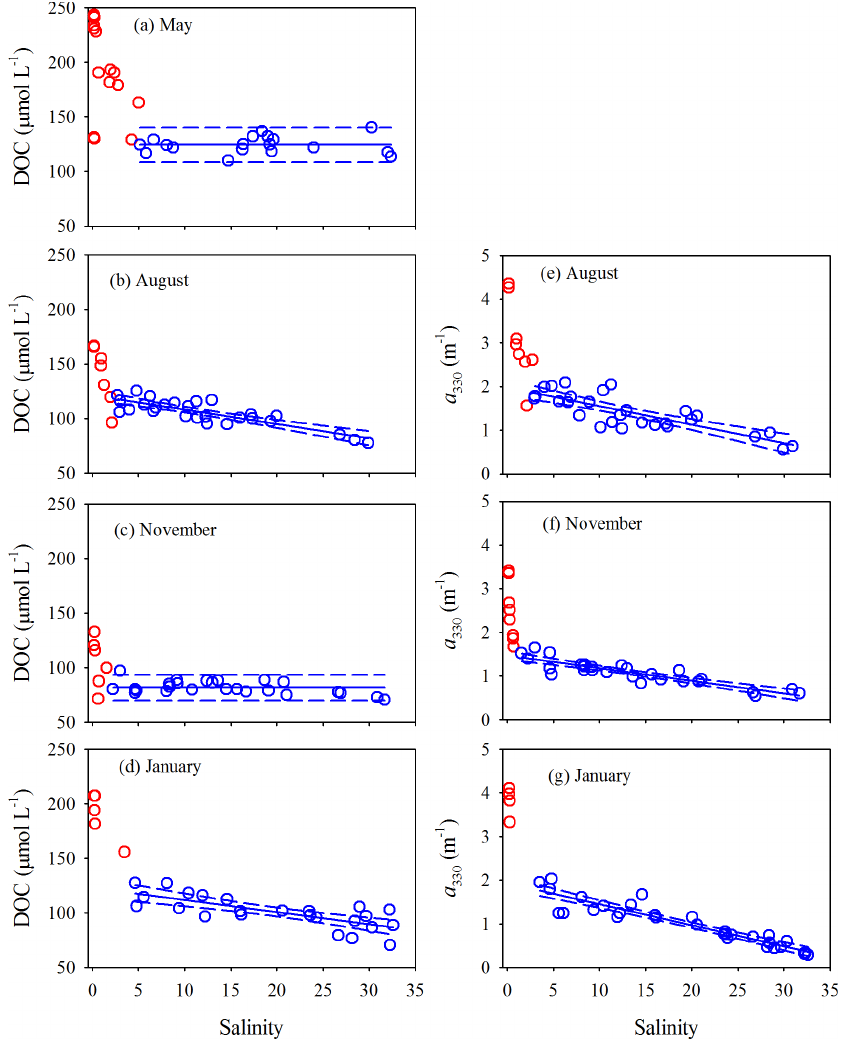
Figure 5. DOC concentration and a 330 versus salinity in the PRE. Red circles denote samples collected in the head region of the estuary where DOC and a 330 showed rapid decreases or large variabilities with salinity. Blue circles denote the samples collected in the main estuary. Solid lines in panels a and c represent means of the blue circles. Solid lines in the other panels denote linear fits of the blue circles. Dashed lines signify the 95% confidence intervals. See Table S3 for fitted equations and